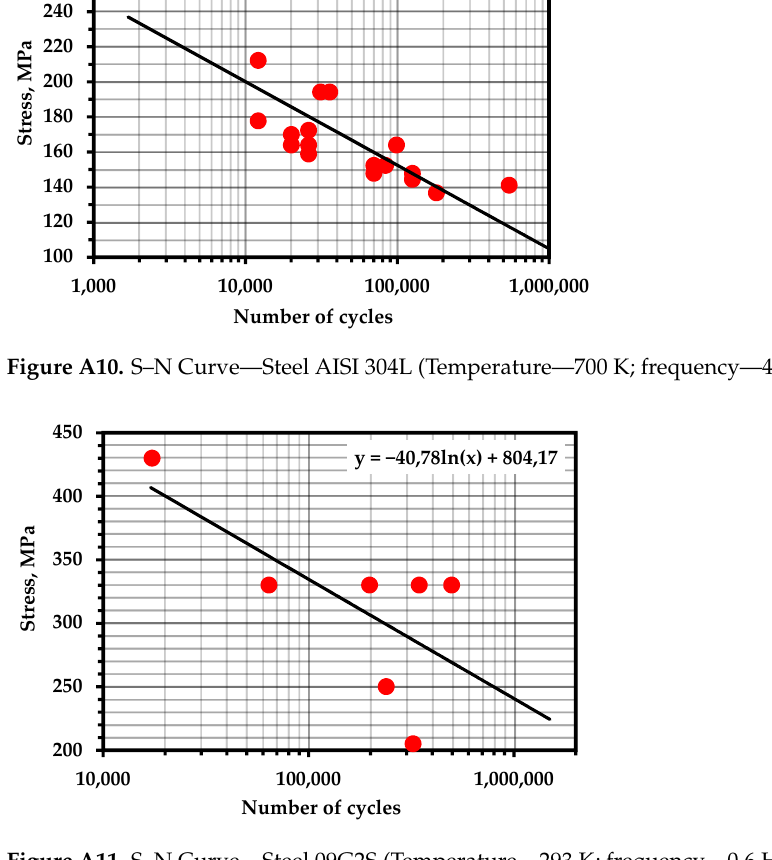
Figure A11. S–N Curve—Steel 09G2S (Temperature—293 К ; frequency—0.6 Hz) [104].